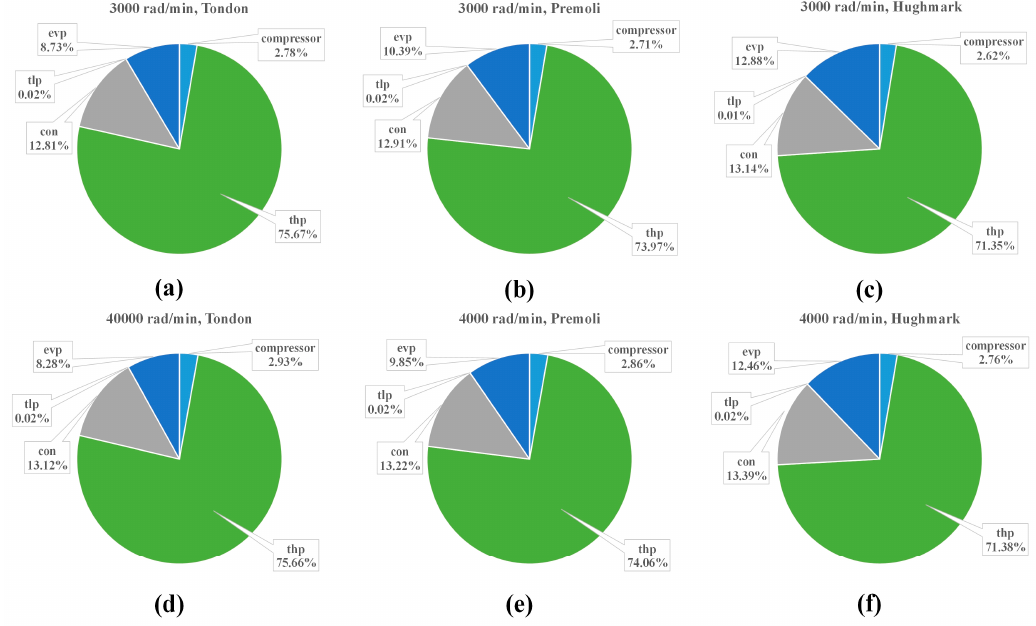
Figure 12. The proportion of each part of charge amount theoretical calculation in heating mode. With different refrigerant charge quantity calculation models under different compressor speeds: ( a ) with Tandon model under 3000 r/min; ( b ) with Prelimi model under 3000 r/min; ( c ) with Hughmark model under 3000 r/min; ( d ) with Tandon model under 4000 r/min; ( e ) with Prelimi model under 4000 r/min; ( f ) with Hughmark model under 4000 r/min.